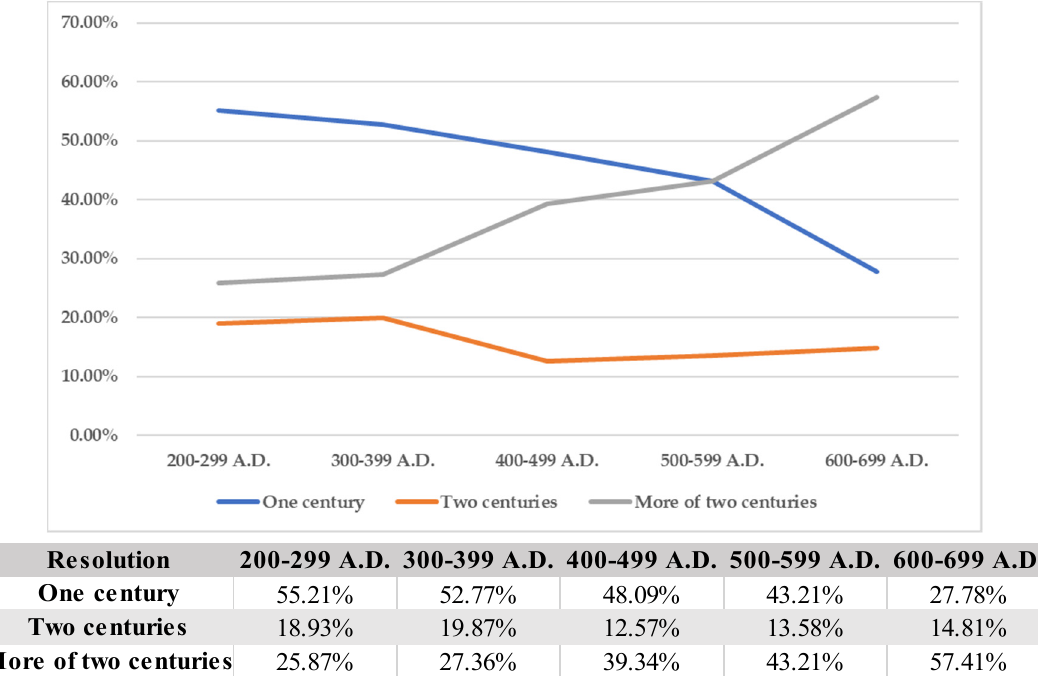
Figure 4. Over centuries of the resolution of the chronological data of the different phases recorded. In percentages with respect to the total number of phases in each chronology. Own elaboration.